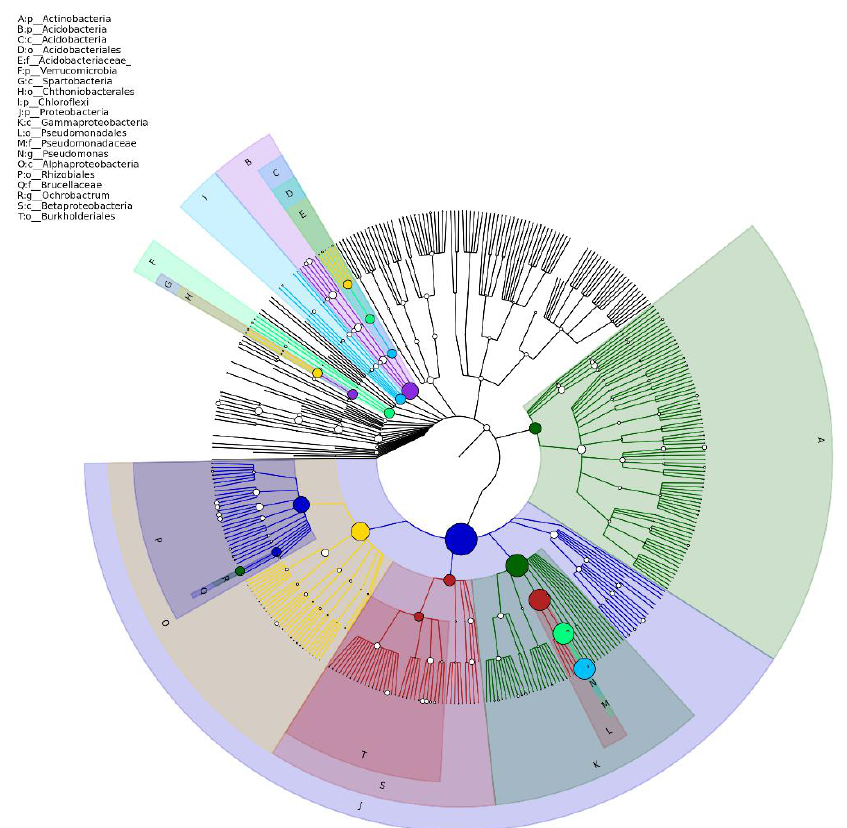
Figure 7. Taxonomic breakdown of the microbiome of the sampled soil bacterial community based on classified 16S rDNA gene sequences. Representative sequences were taxonomically assigned using the RDP (Ribosomal Database Project) classifier. The tree was generated using GraPhlAn (Graphical Phylogenetic Analysis) [27].